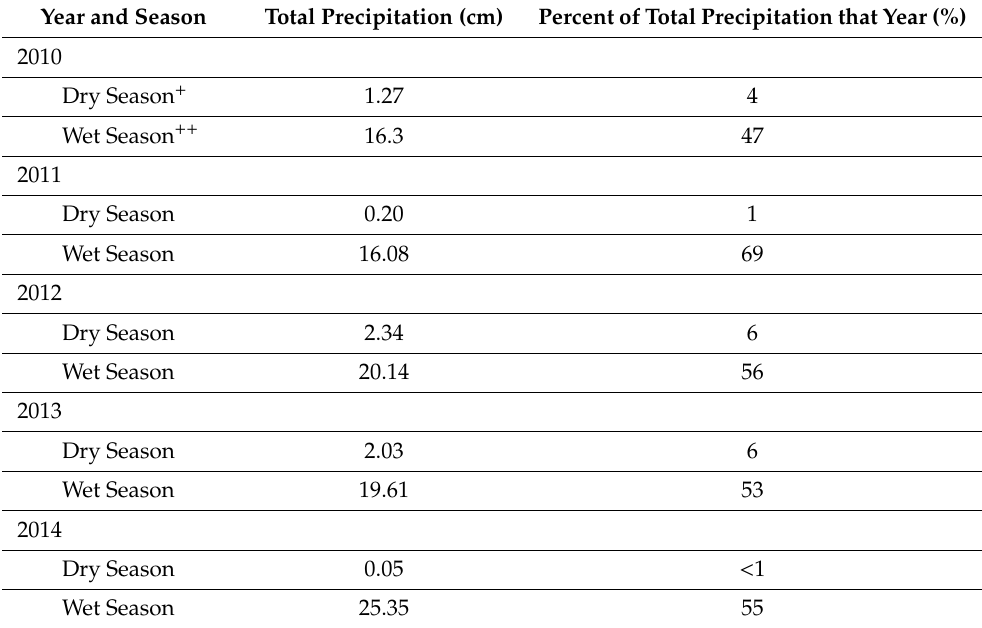
Table 1. Total precipitation by season from 2010 to 2014 in Nogales,